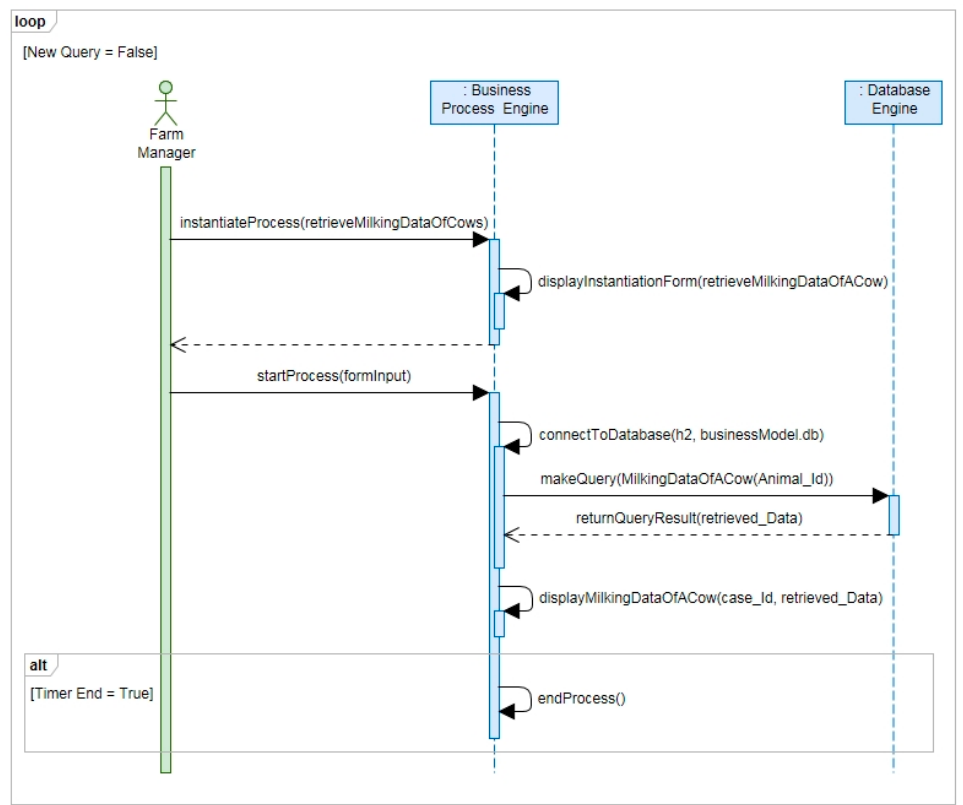
Figure 14. Activity diagram of a business process used to retrieve data from the database. In detail, the diagram shows the collaboration between different software components during the execution of the process “Retrieve Milking Data of a Cow”.